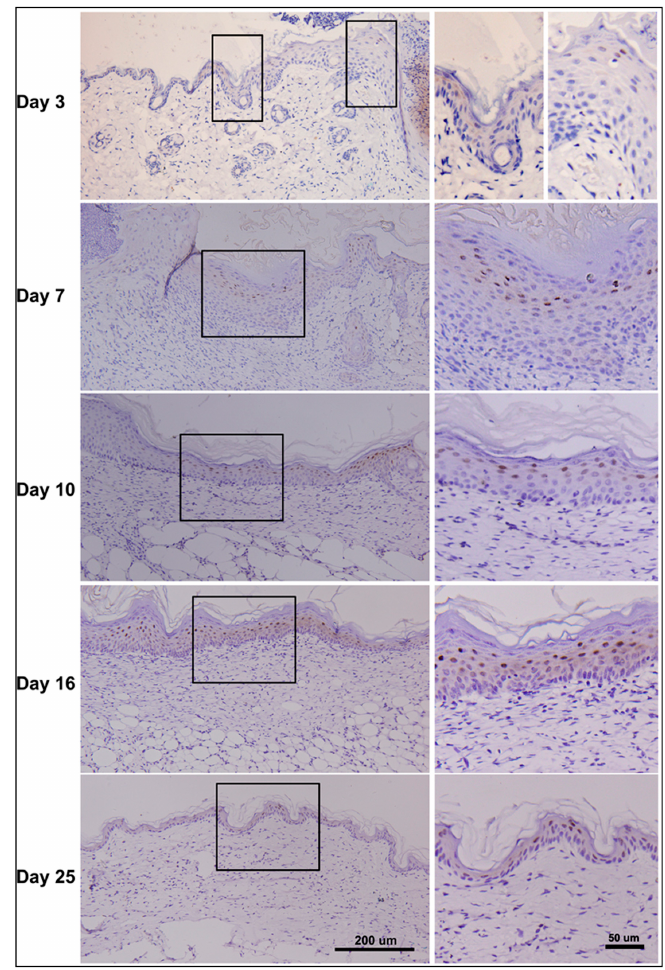
Figure 7. PDCD4 expression during cutaneous wound healing. Full thickness skin incision wounds were created on the backs of male BALB/c mice. The skin wound tissues were collected on the indicated days after wounding and the PDCD4 expression patterns were examined by immunohistochemistry ( left panel ); Partially enlarged drawings were presented ( right panel ); the black boxes ( left panel ) show the sources of the enlarged drawings ( right panel ).